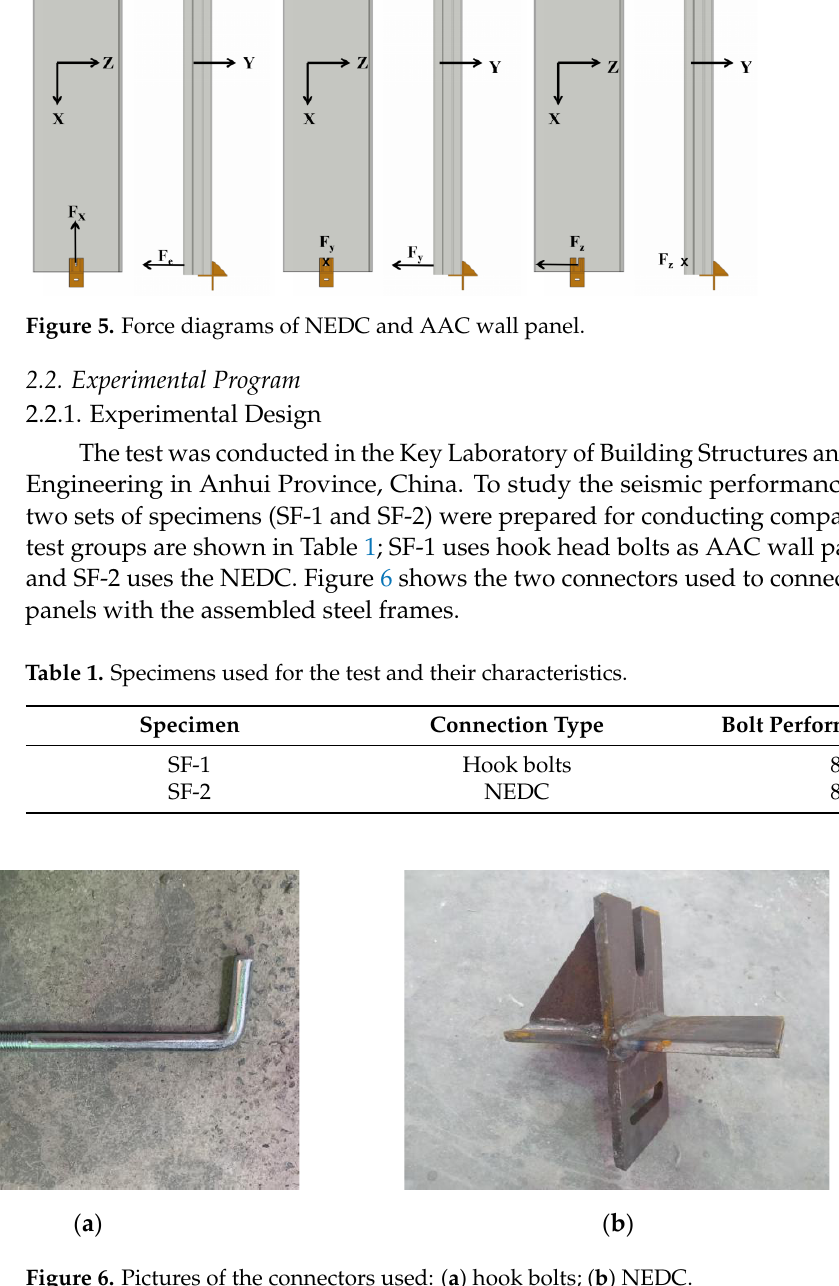
Table 2. Mechanical properties of steel.